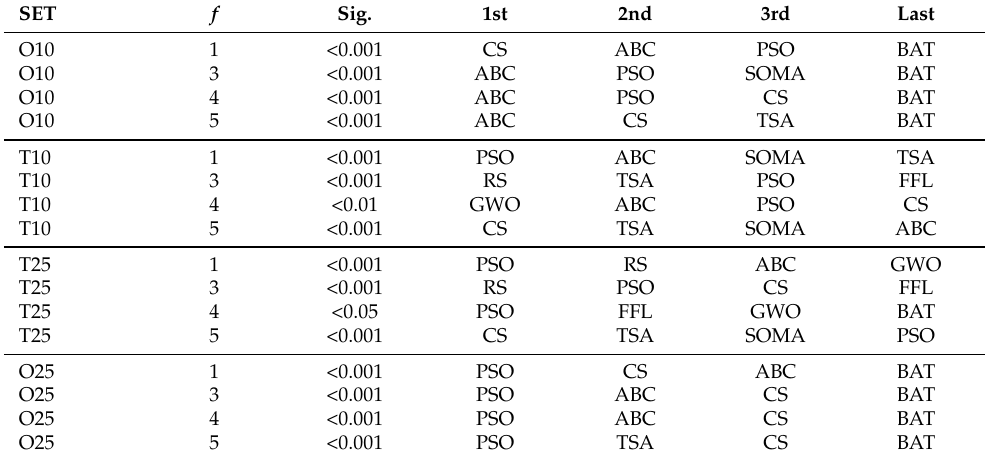
Table 17. The first, second, third, and the last position of all algorithms and each setting from the Kruskal–Wallis tests.